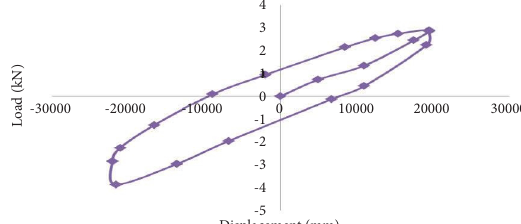
Figure 20: Displacement hysteresis loop for static loading.